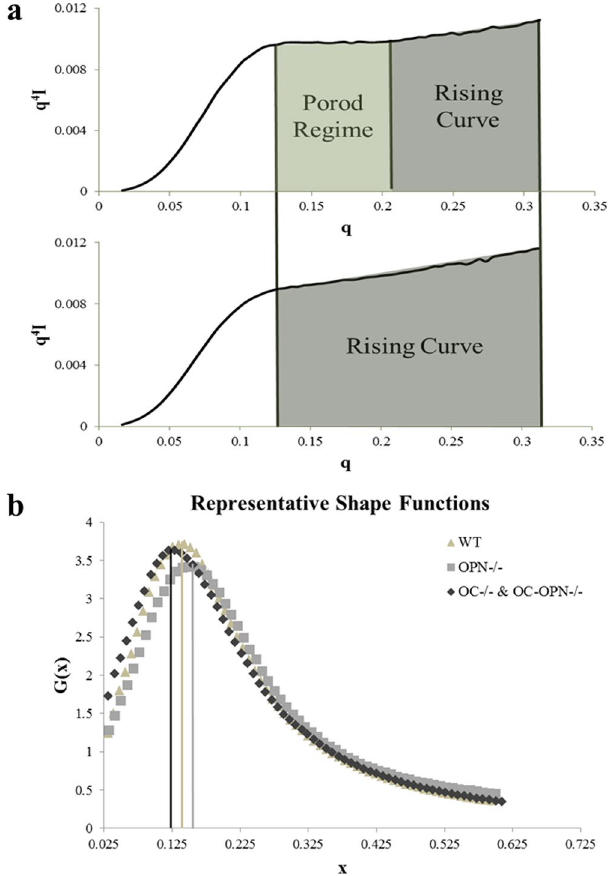
Figure 2. ( a ) Representative plots showing the Porod regime for the WT bone (top) and a deviation from Porod’s law for the double knock-out bones (bottom). ( b ) The Kratky curve shifts to the right in the OPN − / − group indicating rod-like crystals. In the OC − / − and OC-OPN − / − ; − / − groups, there is a shift to the left, indicating more plate-like crystals as compared to